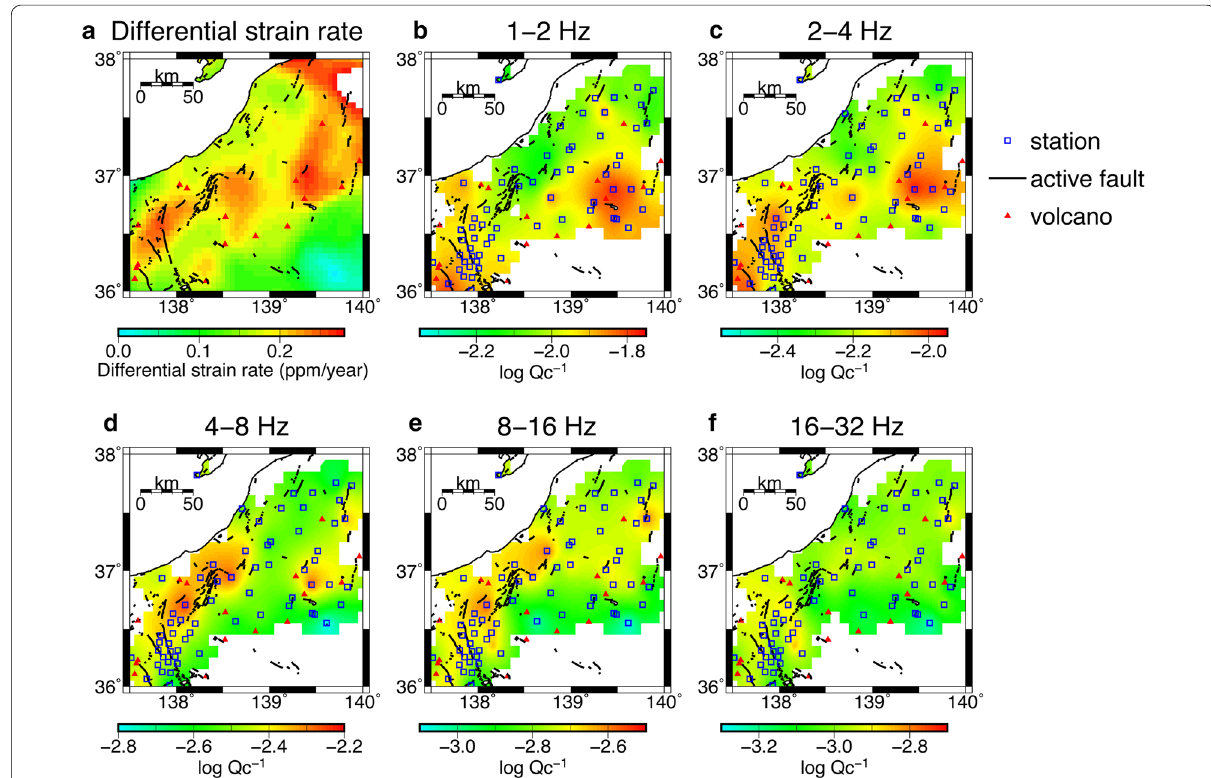
Fig. 3 Spatial distributions of a the differential strain rate during 2012–2014, and b – e the coda Q at five frequency bands in this study area. Blue squares are stations used to draw the coda Q maps, in five frequency bands in this study area, black lines show Quaternary active faults, and red triangles show Quaternary active